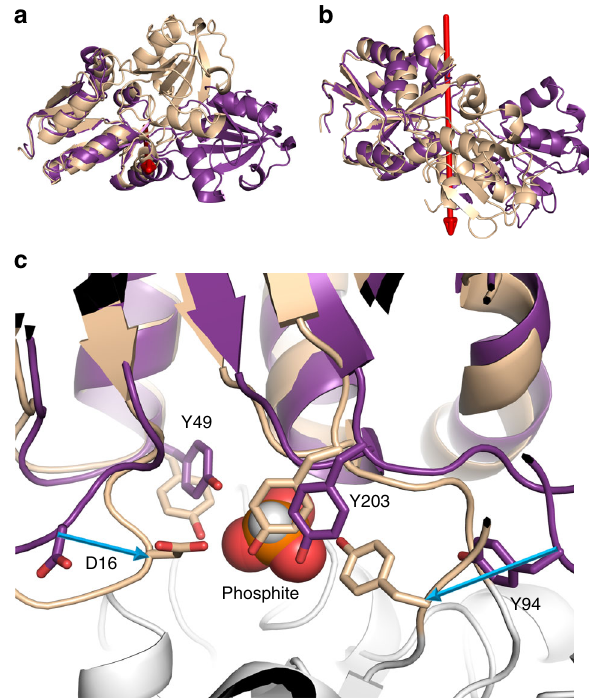
Fig. 4 The conformational change between the open and closed structures of Ps_PtxB. a , b A comparison of the open (purple) and closed (beige) structure of Ps_PtxB, superimposed on lobe 2, showing the 60° rotation of one domain relative to the other around an axis that lies between the two domains (red arrow). c Superimposing the open and closed structures on lobe 2 (lobe 1 is shown in grey) shows that the spatial arrangement of Y49 and Y203 is conserved in both the open and closed states, whilst Y94 and D16, which both sit on fl exible loop regions, undergo large conformational movements (blue arrows) of 7 and 4.5 Å (c α - c α ), respectively. The phosphite is shown as